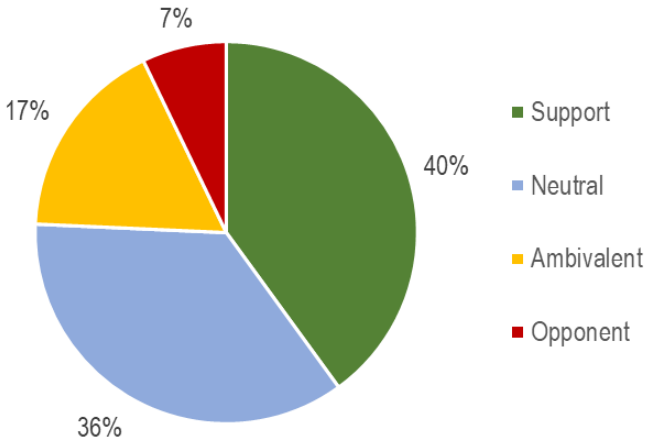
Figure 2. Attitude of stakeholders towards zero-emission heavy-duty trucks.